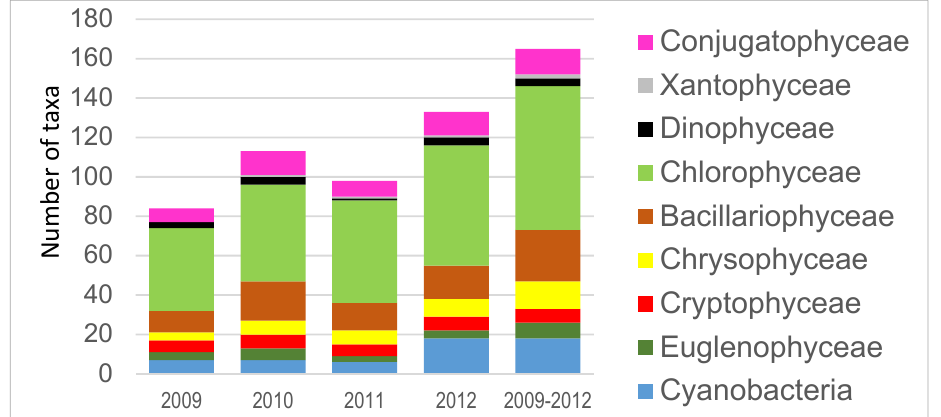
Figure 6. Number of identified taxa in G łę bokie Lake.